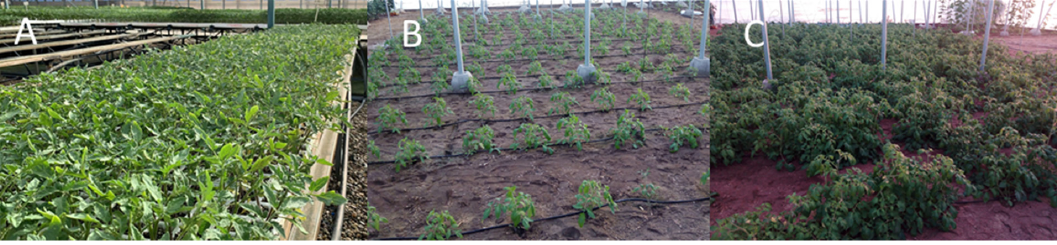
Table 1. Effects of solid media on mass multiplication of P. variotii at varying substrates percentages ( v / v ) and water contents ( v / v ).